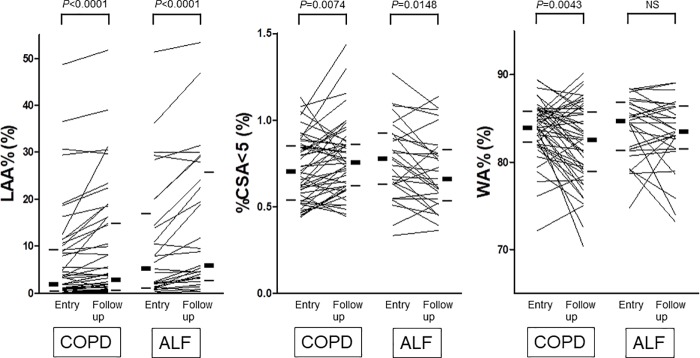
Changes in radiological parameters over two years of follow-up.Notes: Radiological parameters were compared between enrollment and two-year follow-up with the Wilcoxon signed-rank test. WA% shows the mean wall area percentage at the 5th generation of bronchi. The thick horizontal bars at the sides of each graph show the median, while the thin horizontal bars at the sides of each graph show the interquartile range. Abbreviations: ALF, asthma-like features; LAA, low-attenuation area; CSA<5, the cross-sectional area of pulmonary vessels < 5 mm2; WA%, wall area percentage; NS, not significant.